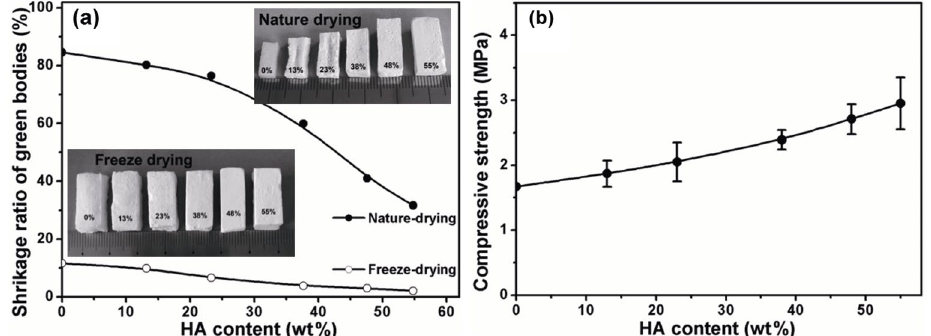
Fig. 1 (a) Effect of the HA content and drying methods on the near-net-shape forming of green bodies. (b) Compressive strength as a function of the HA content in the freeze-dried green bodies (mean±s.d., n = 5).